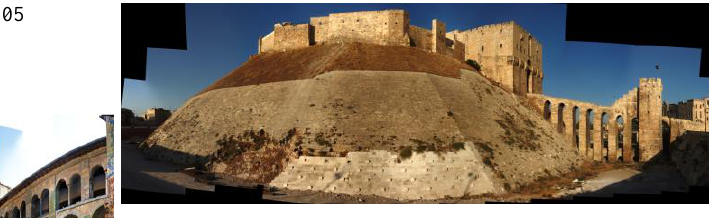
Figure 27 – Aleppo the Citadel walls before the war